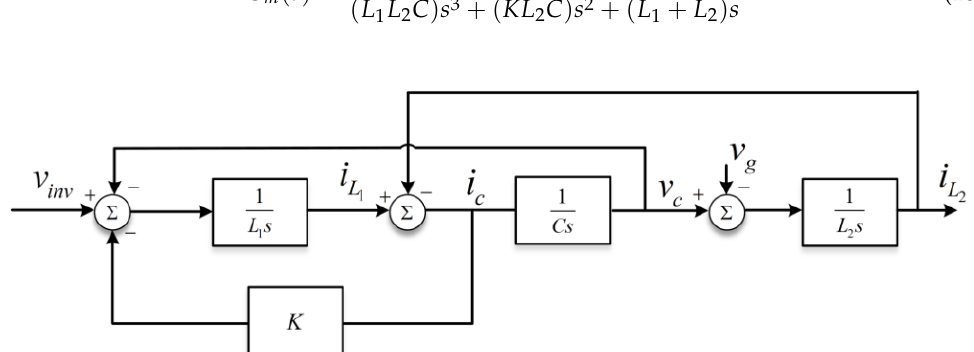
Figure 4. Block diagram of the active damping. 𝑉 𝑖𝑛𝑣 = 𝑚𝑉 𝐷𝐶 , 𝑖 𝐿1 = 𝑖 1 , 𝑖 𝐿2 = 𝑖 2 , and 𝑣 𝑔 = 𝑣 𝑔𝑟𝑖𝑑 .